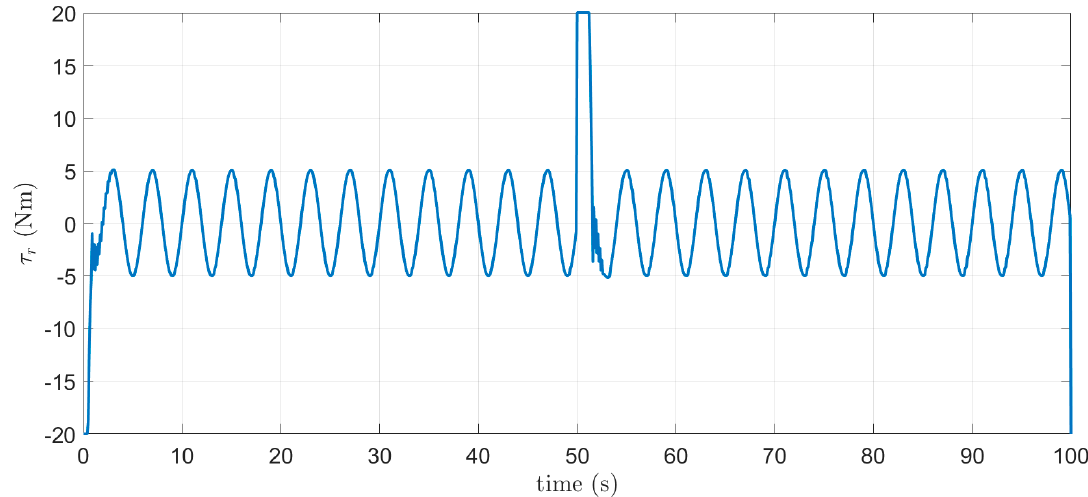
Figure 12. Simulation results of heading performance with robust control. ( a ) Heading angle is regulated to −30° and 30° . ( b ) Yaw rate is regulated at 0 degrees/s.